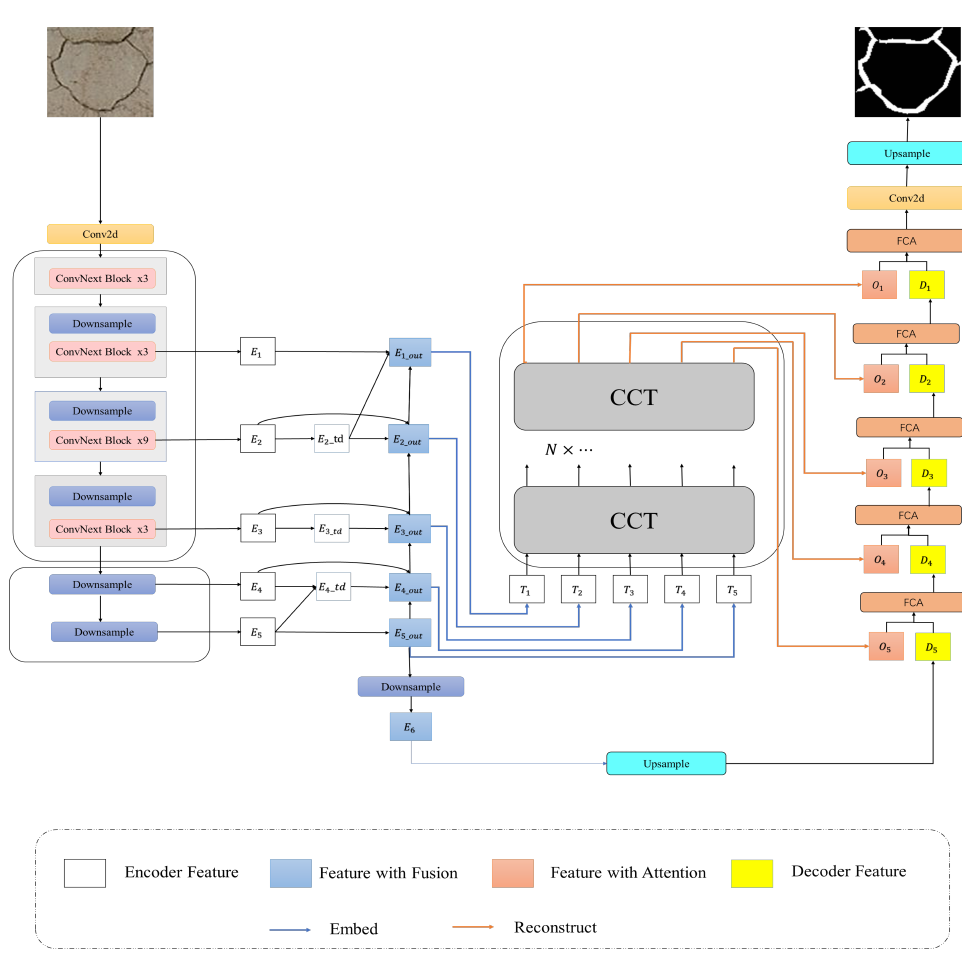
Figure 3. Overall model framework of TMCrack-Net.